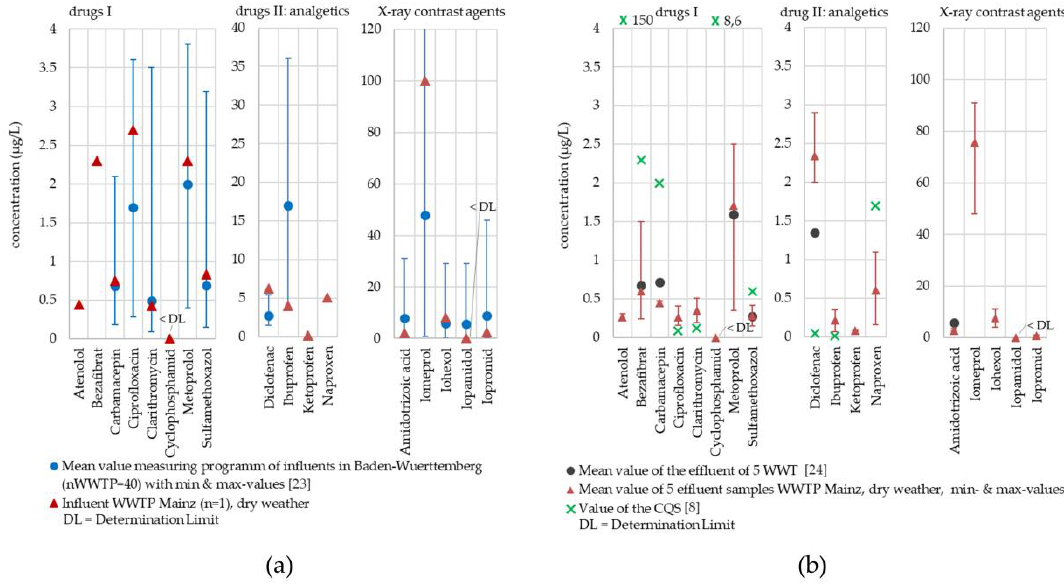
Figure 2. Micropollutant concentrations at WWTP Mainz compared to results from other WWTP: ( a ) Inflow values of WWTP Mainz compared to results in [23] and ( b ) effluent values of WWTP Mainz compared to values in [24] complemented by chronic quality standard (CQS)-values.